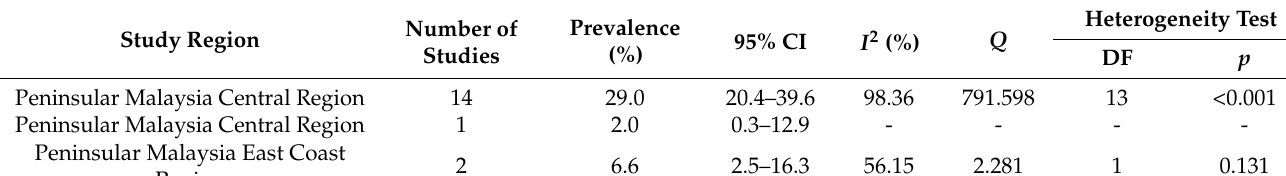
Table 3. Subgroup analysis for comparison of VRE in poultry in Malaysia across study region.